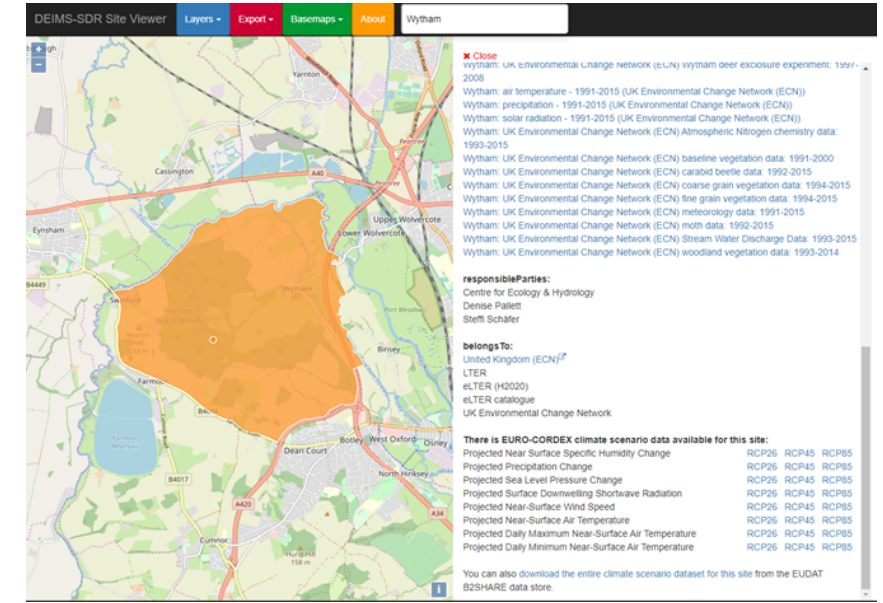
Figure 6. Data discovery on the DEIMS-SDR site